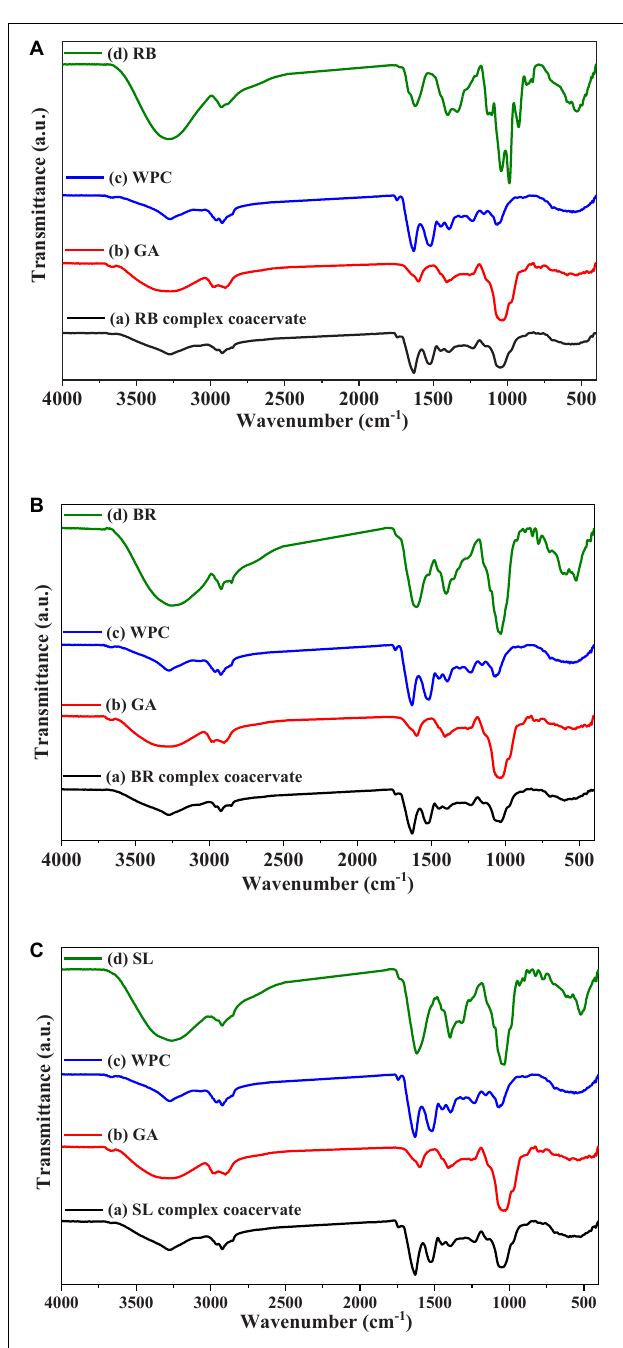
FIGURE 4 | FTIR spectrum of the red beet (RB) (A) , broccoli (BR) (B) , and spinach leaf (SL) (C) powdered extracts encapsulated with different wall materials. WPC, whey protein concentrate; GA, gum